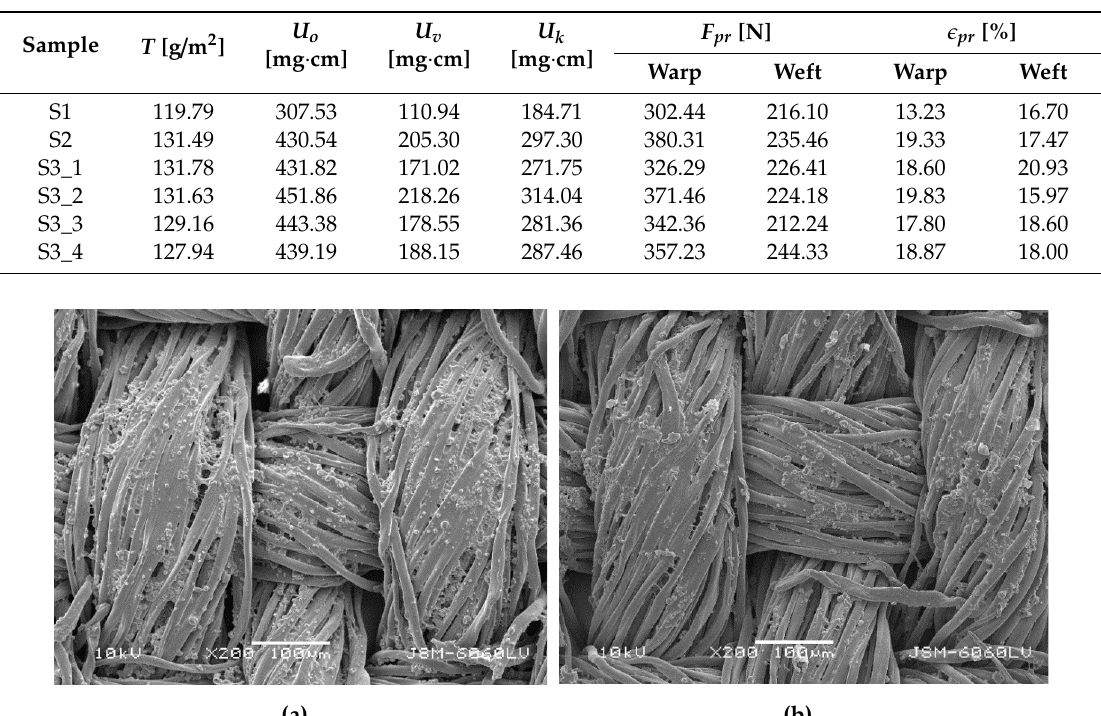
Table 2. Mass per unit area ( T ), sti ff ness in the warp ( U o ) and weft ( U v ) directions, overall flexural rigidity ( U k ), breaking force ( F pr ) and breaking elongation ( (cid:15) pr ) in the warp and weft directions of the studied samples.